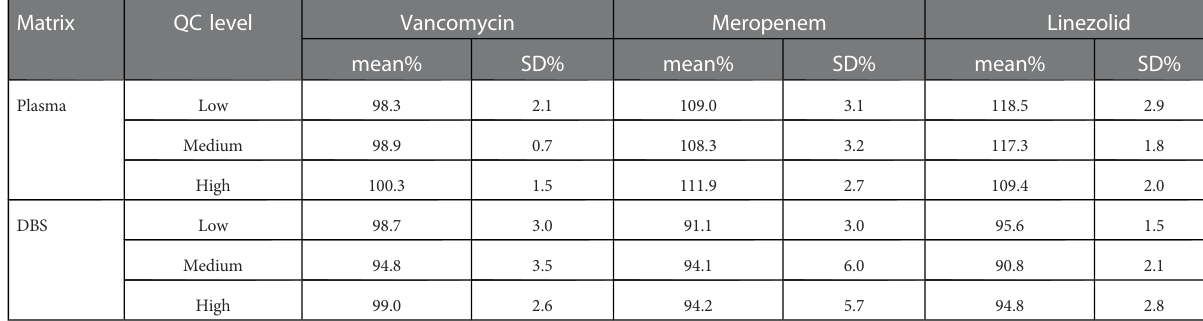
TABLE 3 Results of the matrix effect for vancomycin, meropenem, and linezolid in plasma and DBS ( n =6). Matrix